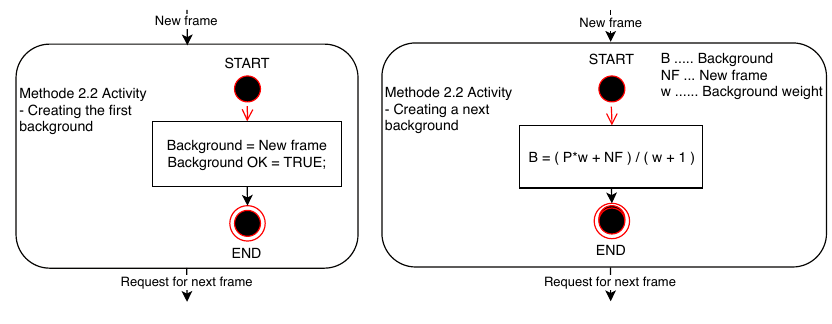
Figure 12. Diagrams of Method 2.2 activity.